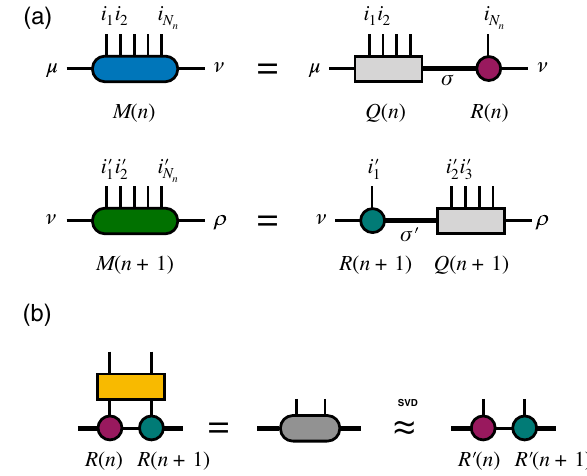
FIG. 11. Main steps for applying a gate which acts across two grouped MPS tensors, as described in Eqs. (34) and (35). In (a) the grouped MPS tensors M ð n Þ and M ð n þ 1 Þ are exactly factorized using QR decompositions, such that the R ð n Þ and R ð n þ 1 Þ tensors carry the qubit indices acted on by the gate and the newly introduced indices σ and σ 0 range over 2 χ values. In (b) the gate acts on the product of R ð n Þ and R ð n þ 1 Þ , and the resulting tensor is factorized using a SVD truncated to χ singular values. Finally, to update the MPS (not shown), one computes the new tensors M 0 ð n Þ ¼ Q ð n Þ R 0 ð n Þ and M 0 ð n þ 1 Þ ¼ R 0 ð n þ 1 Þ Q ð n þ 1 Þ , which diagrammatically looks like step (a) but in